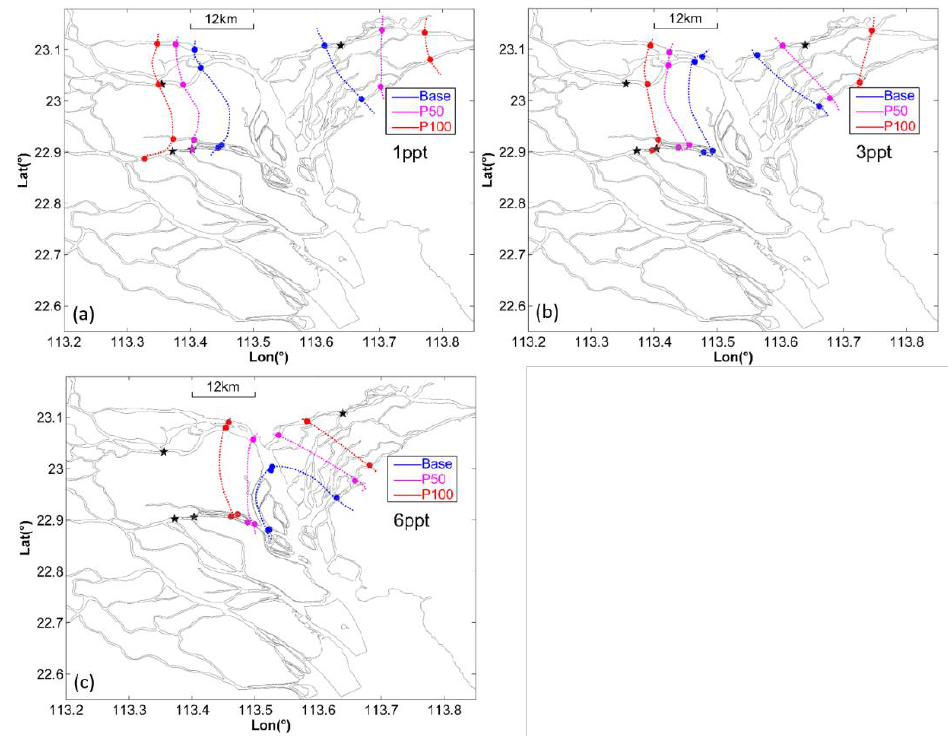
Figure 5. Locations of depth-averaged salinity isohalines in the upper reaches of the PRE for the base case and each sea-level rise case. ( a ) 1 ppt; ( b ) 3 ppt; ( c ) 6 ppt. The results are average values from January 2008.